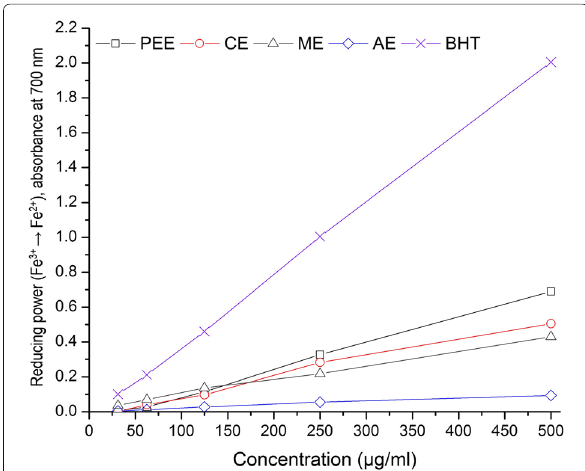
Fig. 3 Reducing power of different extracts of C.pallida stem and standard antioxidant. All tests were done three times. PEE-Petroleum ether extract, CE- Chloroform extract, ME-Methanol extract, AE-Aqueous extract, BHT-Butylated hydroxytolune